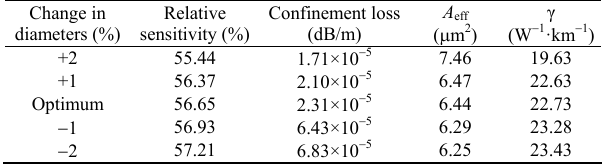
Table 1 Comparison of different index-guiding properties for optimum design parameters and also for fiber’s global diameter variations of order ± 1 % – ± 2 % around the optimum value.